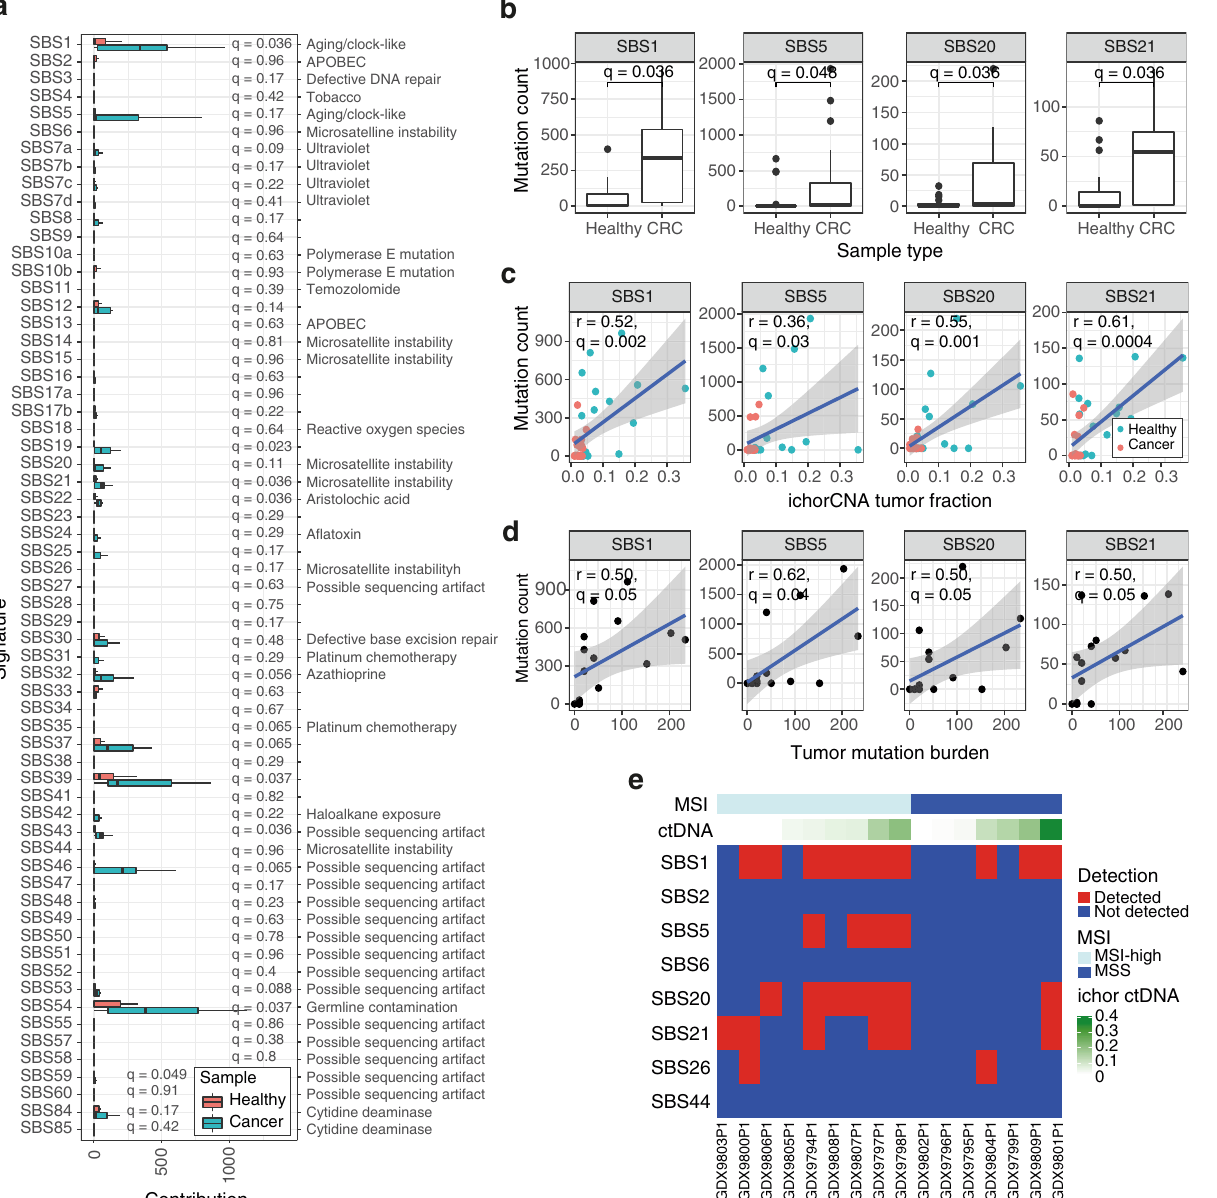
Fig. 2 | Signature pro fi ling in stage IV colorectal cancer (CRC).a The number of mutations fi tted to each signature is shown for plasma WGS data from healthy controls ( n =19, shown in red) and individuals with stage IV CRC ( n =16, shown in blue). Background subtraction was performed, and SNPs were retained ( “ Meth- ods ” ). The potential etiology of each signature is listed 12,45 . Boxplots represent the median, upper and lower quartiles and whiskers indicate 1.5× IQR. One-sided Wil- coxon tests wereperformed, and Benjamini – Hochberg(BH)-corrected p values ( q ) are shown. APOBEC apolipoprotein B mRNA-editing enzyme. b Boxplots of aging and MSI signature contributions in healthy individuals ( n =19) and patients with CRC ( n =16). Mutation counts are background-subtracted ( “ Methods ” ). One-sided Wilcoxon tests were performed, and adjusted p values ( q ) are shown. Boxplots represent the median, upper and lower quartiles, and whiskers indicate 1.5× IQR. c One-sided Pearson correlations between tumor fraction and background-